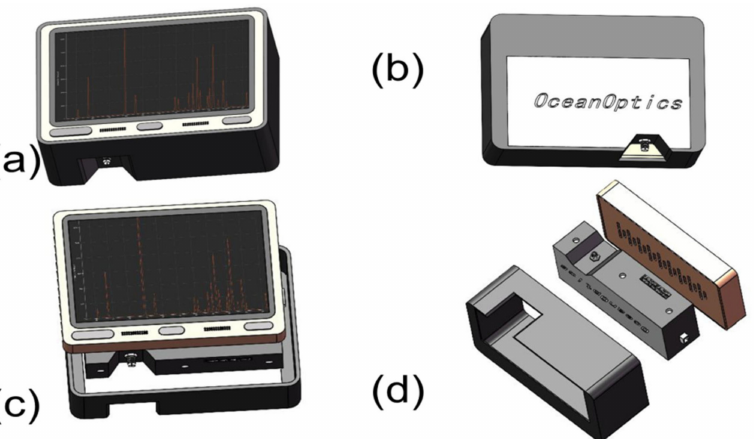
Figure 1. ( a ) The GOLE1 mini-computer used in the experiment. ( b ) The Ocean Optics USB2000+ spectrometer that was used in the experiment. ( c ) Front view of the assembly of the mini-computer and the spectrometer; ( d ) Integration of the spectrometer and the mini-computer through a self- designed